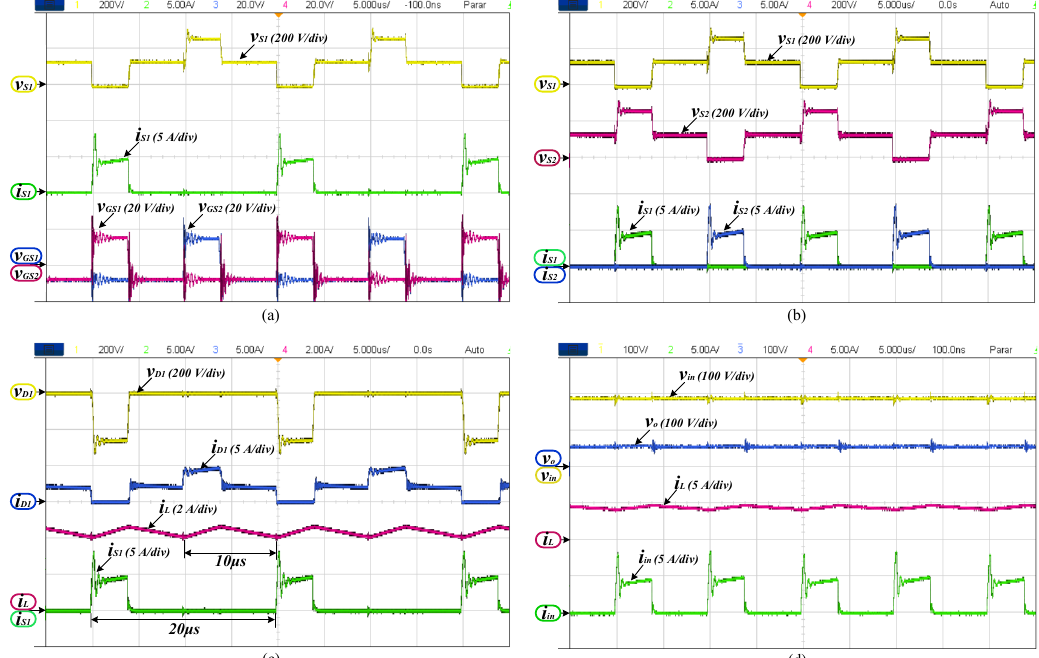
Figure 10. 3SSC-A-based buck experimental results at full load (time: 5 µ s/div.): ( a ) v S i S (5 A/div); V GS 1 i S (5 A/div); ( c ) v D 2 (5 A/div); v in (100 V/div); i in (5